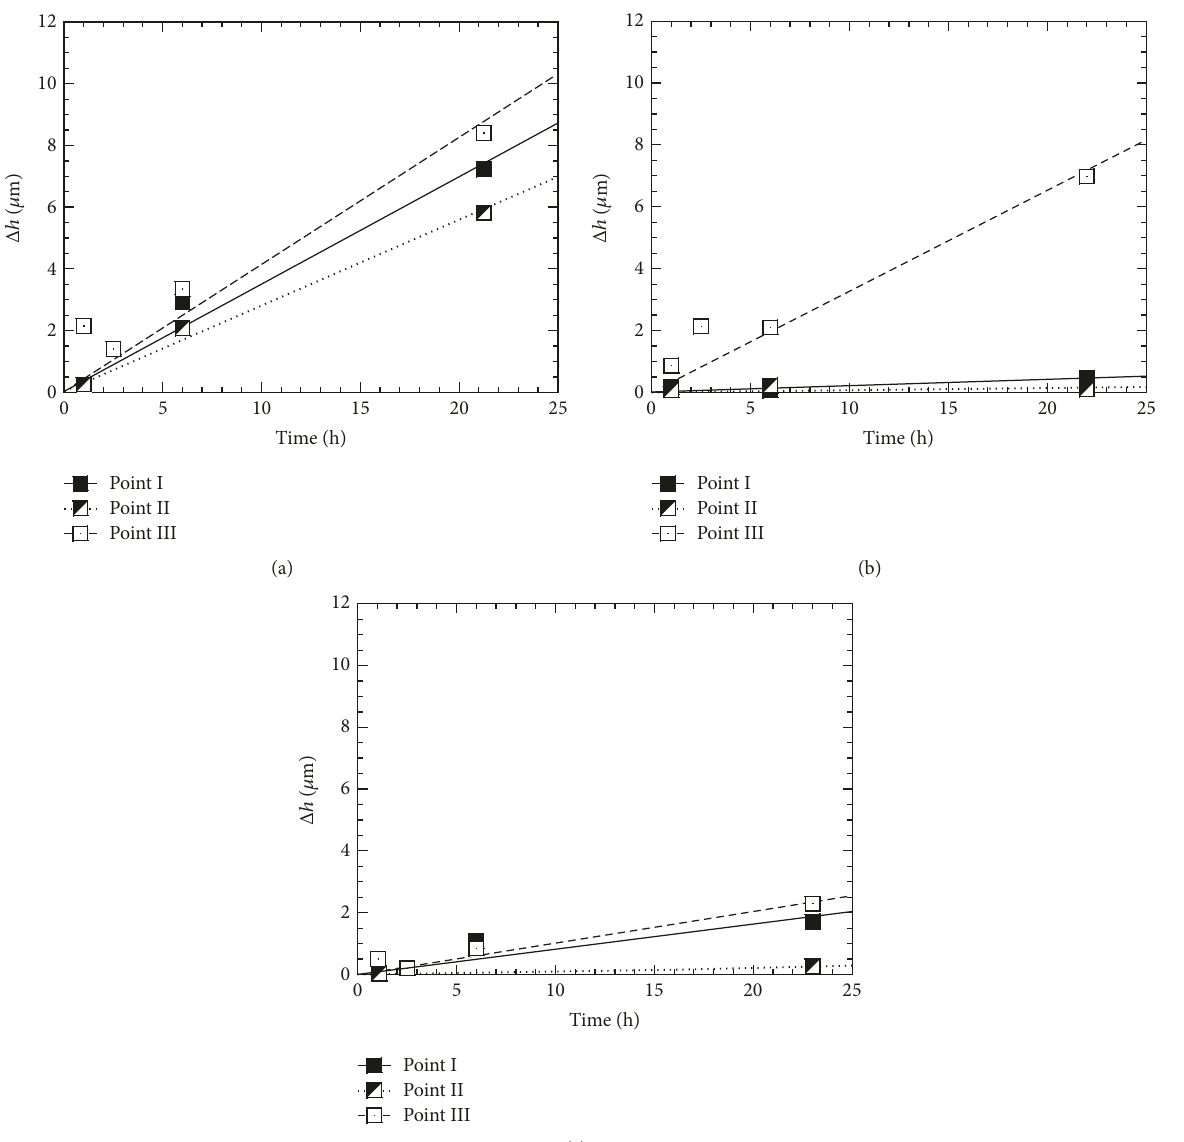
Figure3:Timecoursechangeof Δℎ ofcalciteineachrun:(a)RunA,(b)RunB,and(c)RunC.Eachlinecorrespondstoalinearapproximation passing through the